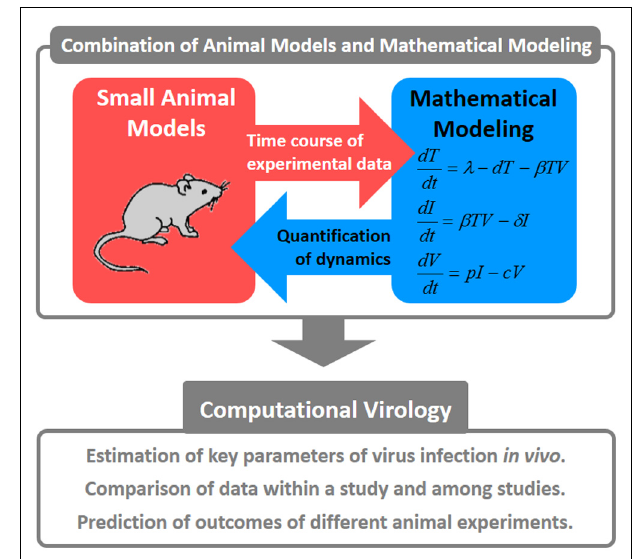
FIGURE 1 | Concepts for combining animal models with mathematical modeling. These quantitative approaches are referred to as “computational virology.”This has the potential to provide novel insights into viral pathogenesis, the development of antiviral drugs, and the establishment of effective therapies against viral